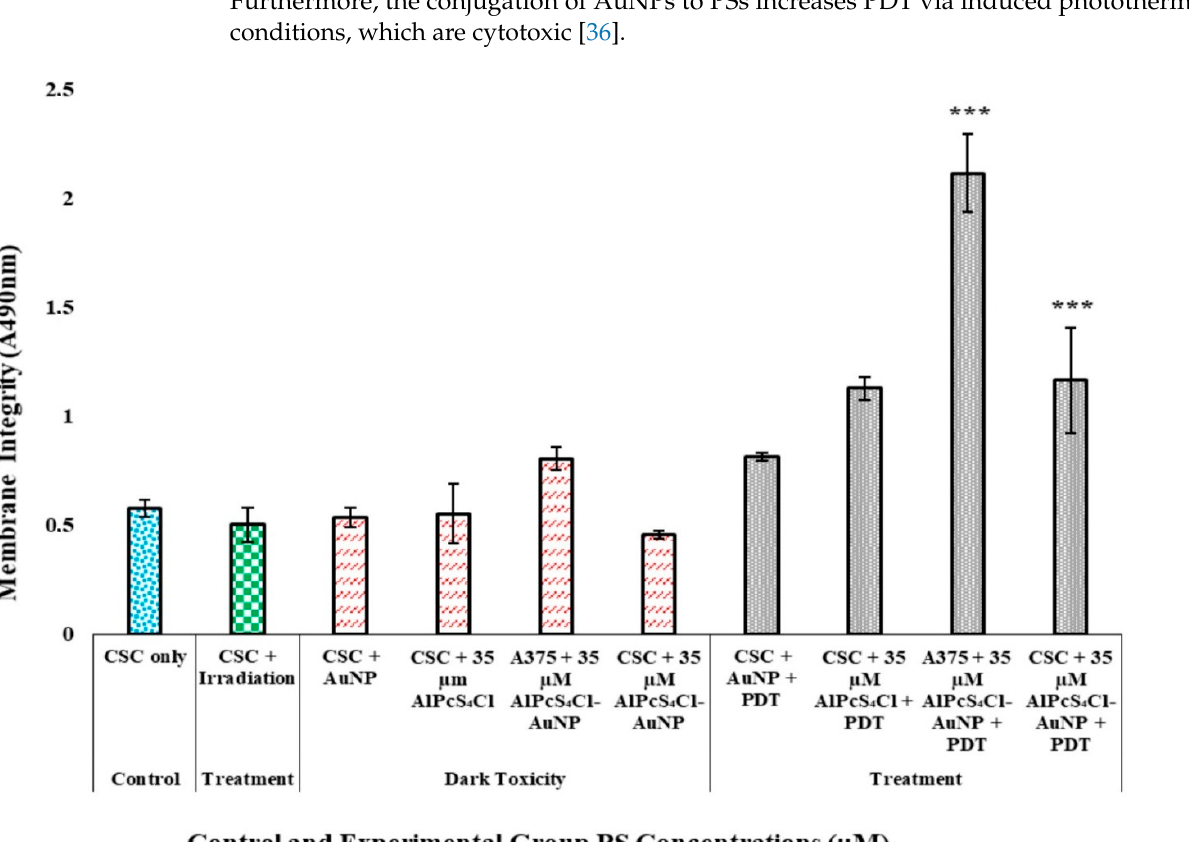
Figure 7. Post-irradiation cytotoxicity analysis of A375 using LDH assay for control, treatment, and dark-toxicity cell groups (measured as an absorbance value at 490 nm). A375 total cell population and A375 CSC treatment group with dose of 35 M AlPcS 4 Cl-AuNP, with a p < 0.01 significance (***). Control, treatment, and dark-toxicity cell groups received PS dose and laser irradiation at 673.2 nm, radiant exposure: 5 J/cm 2 .